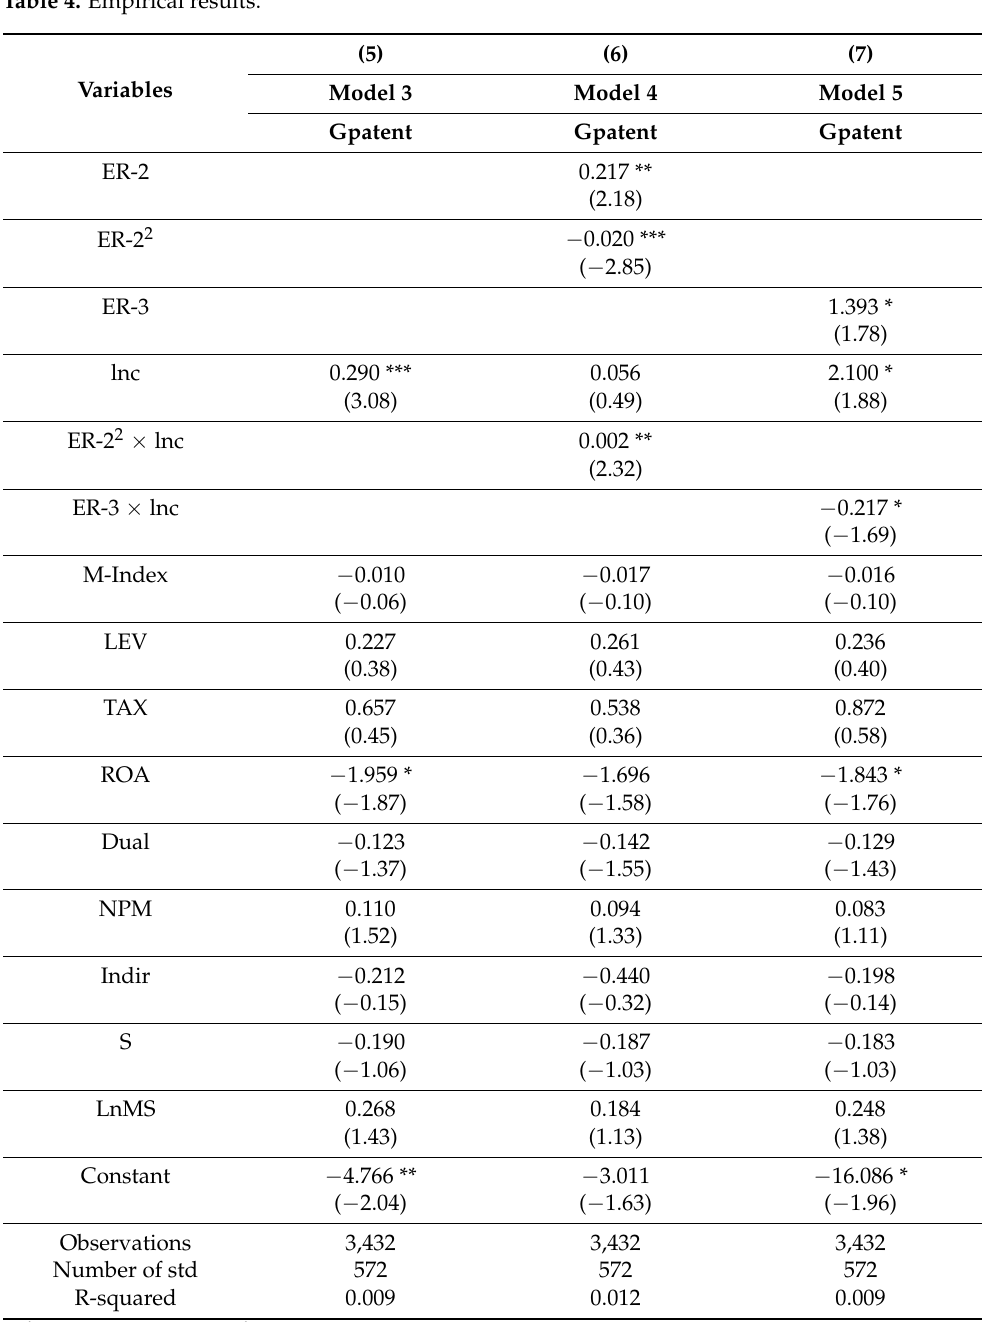
Table 4. Empirical